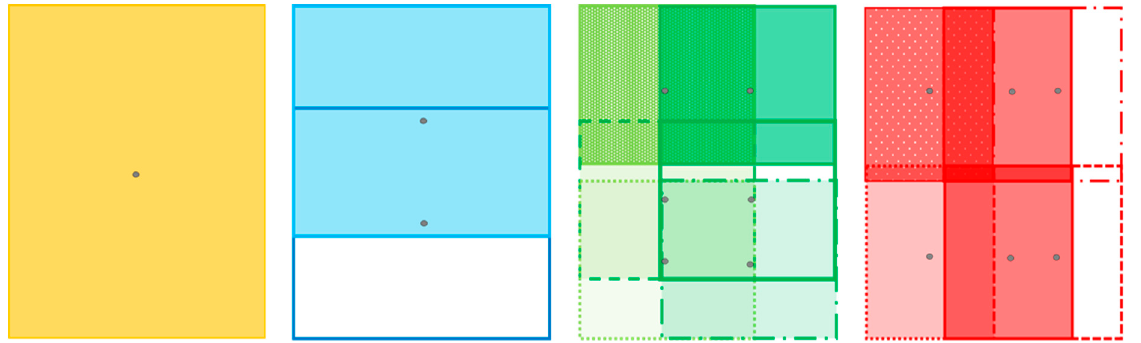
Figure 4. Illustration region’s method RMAC+.